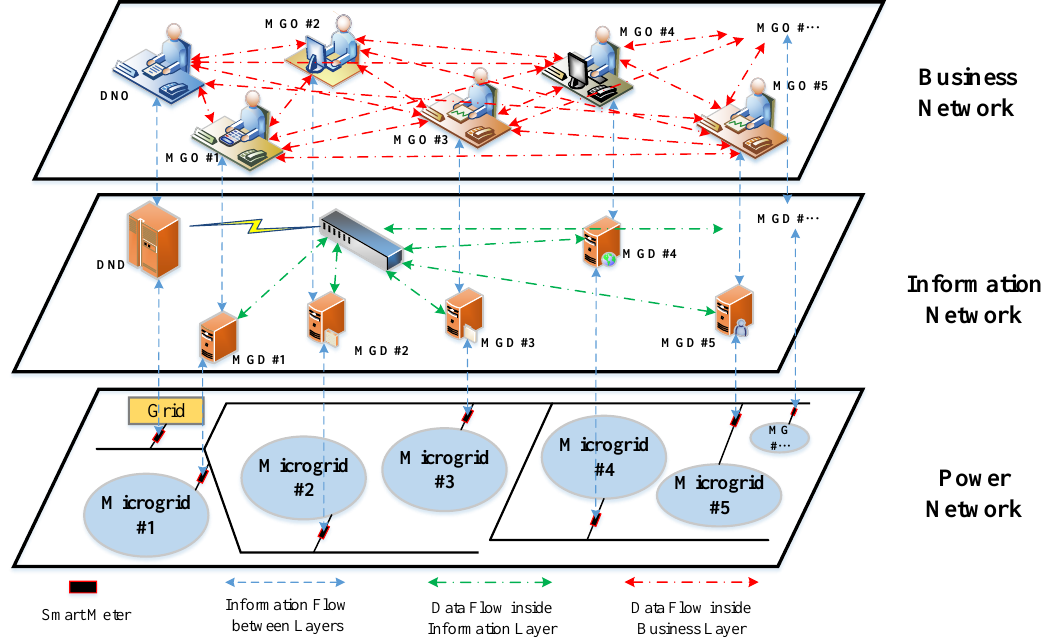
Figure 1. The structure of a typical distribution network for peer-to-peer (P2P) energy trading. The power network is composed of several networked microgrids that are situated in different geographical locations, in which DGs, DESs, DLs, EVs, and general loads are connected to distributed connection points. The internal topology of each microgrid is also different. These microgrids can operate individually or in conjunction with each other. For example, each microgrid can supply its power demand not only by dispatching distributed energy resources but also by importing power from neighboring microgrids or the